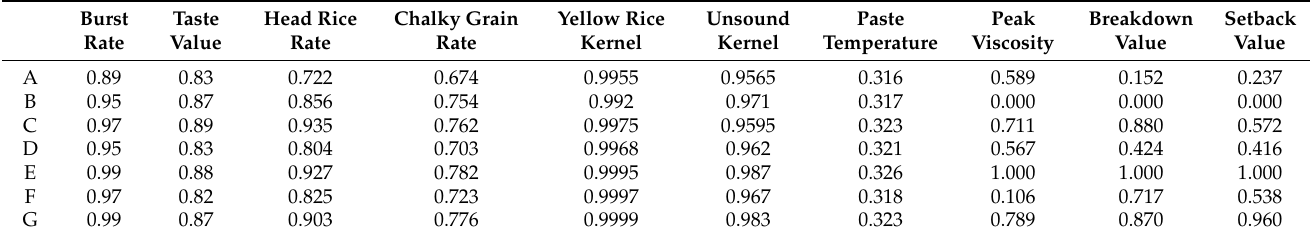
Table 4. Normalized values of paddy quality indexes.